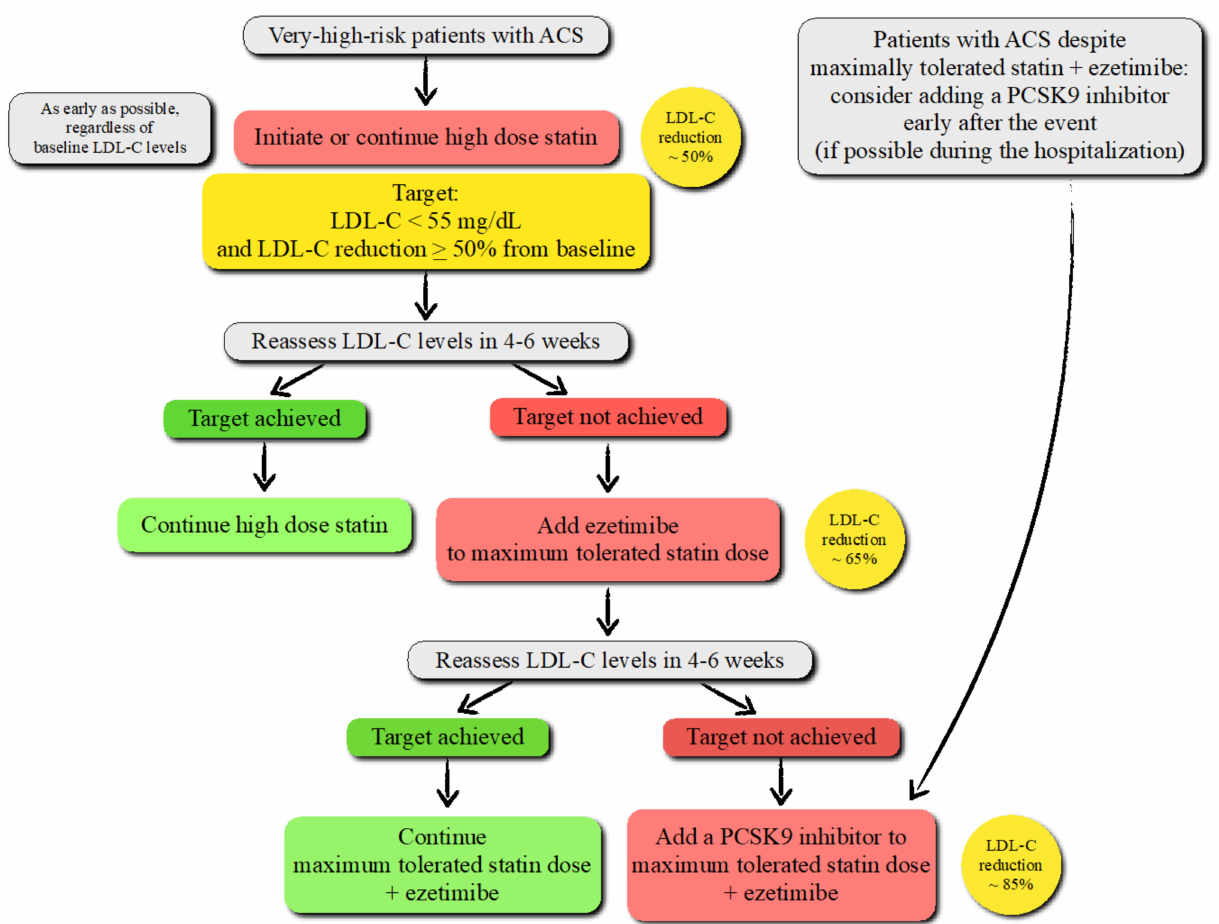
Figure 5. Treatment algorithm to pharmacologically decrease low-density lipoprotein cholesterol (LDL-C) levels in pa- tients with acute coronary syndrome (ACS) according to the recent European Society of Cardiology (ESC)/European Atherosclerosis Society (EAS)